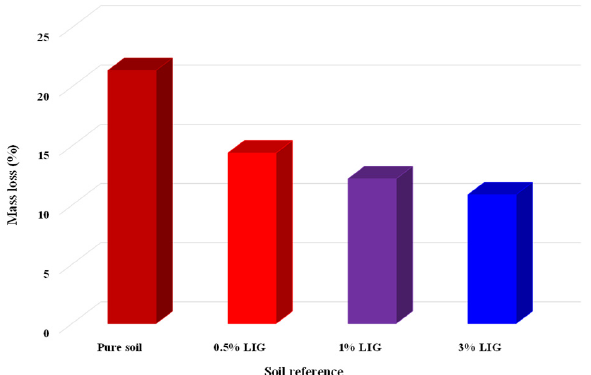
Figure 10. Soil mass loss after exposure to atmospheric conditions.